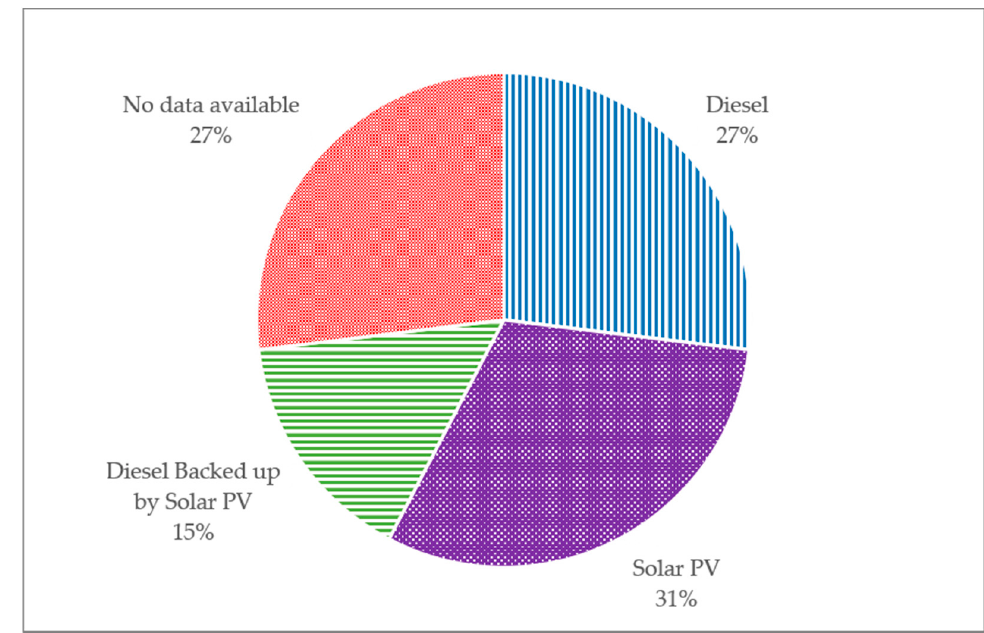
Figure 6. Source of electricity for HCFs with unreliable electricity access.